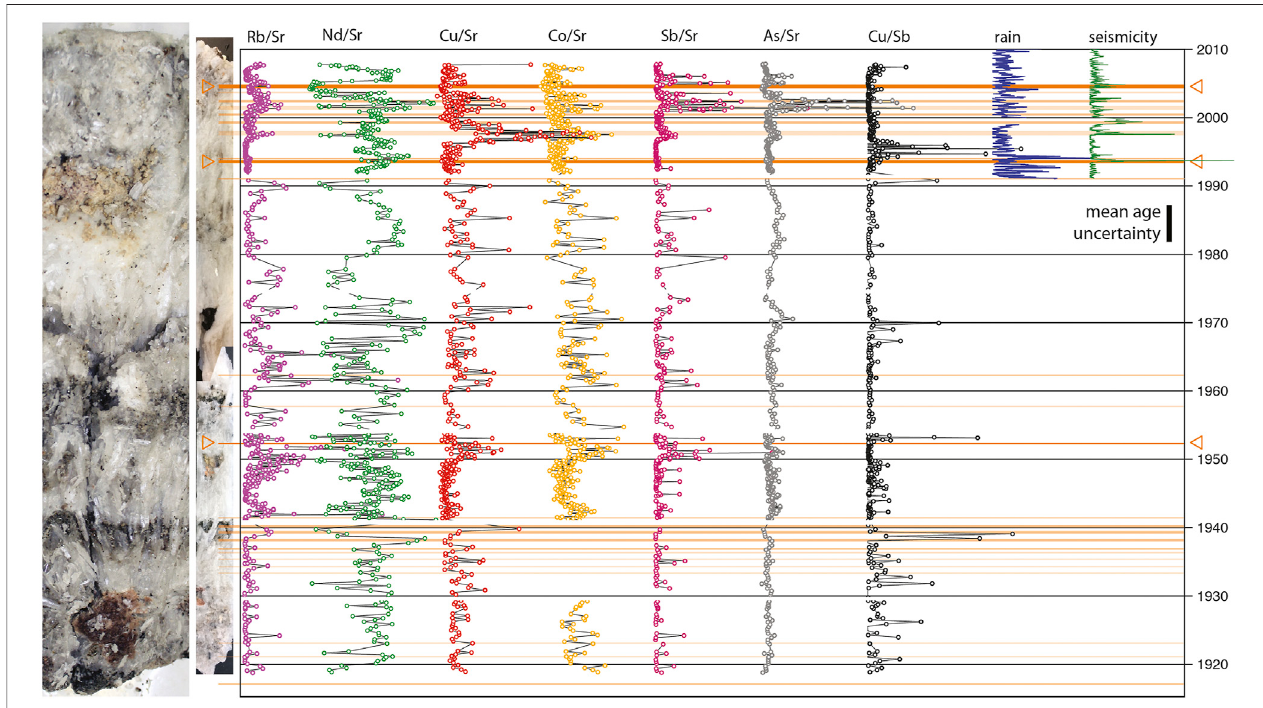
FIGURE 9 | Timeseries for selected elements along the gypsum transect with known periods of unrest overlain. The main volcanic unrest within this time period took place in 1952, 1993 and 2004 (marked with a triangle). Events that involved explosions or columns of water are shaded a darker hue that those that only involved gas upwelling and/or temperature fl uctuations. Precipitation and the sum of seismic events from Caudron et al. (2015b) are shown for comparison.